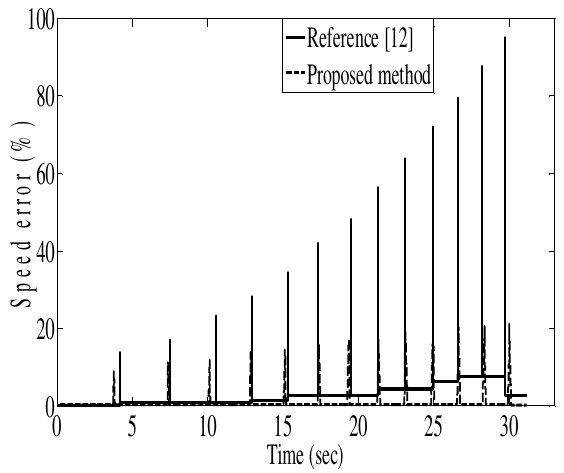
Fig. 10. Comparison of Speed error resulting from decreasing segment